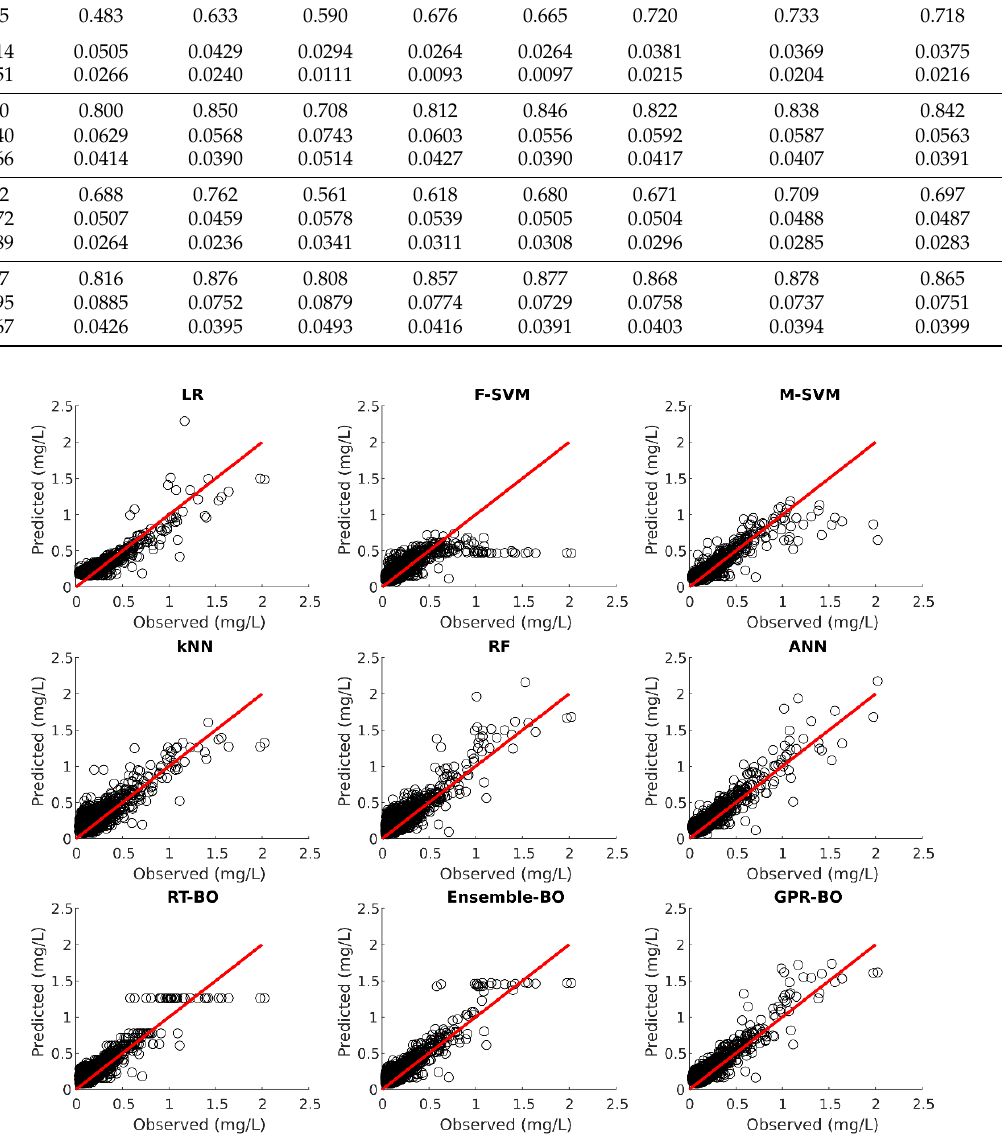
Figure 8. Observed versus predicted daily phosphorus concentration for the Cuyahoga using different ML algorithms.